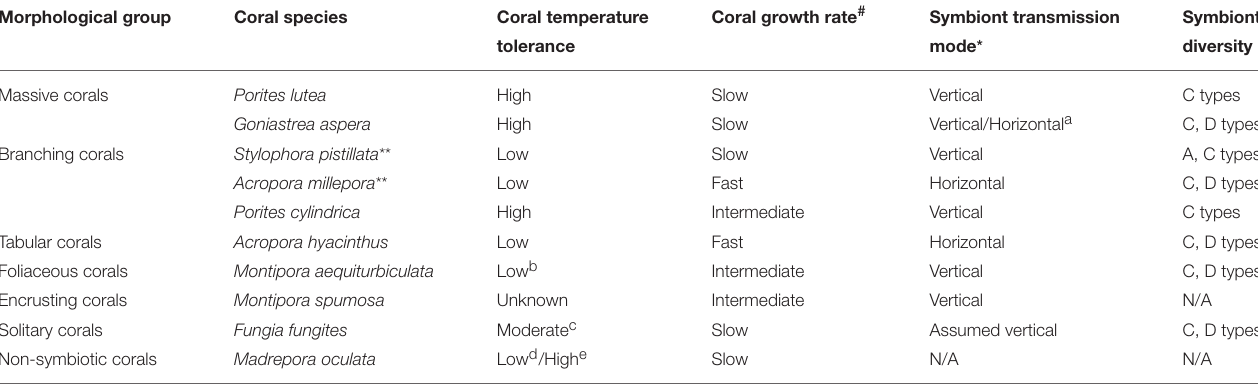
TABLE 1 | Selection of 10 initial coral species and organismal attributes targeted for hologenome sequencing in the ReFuGe 2020 Consortium. Morphological